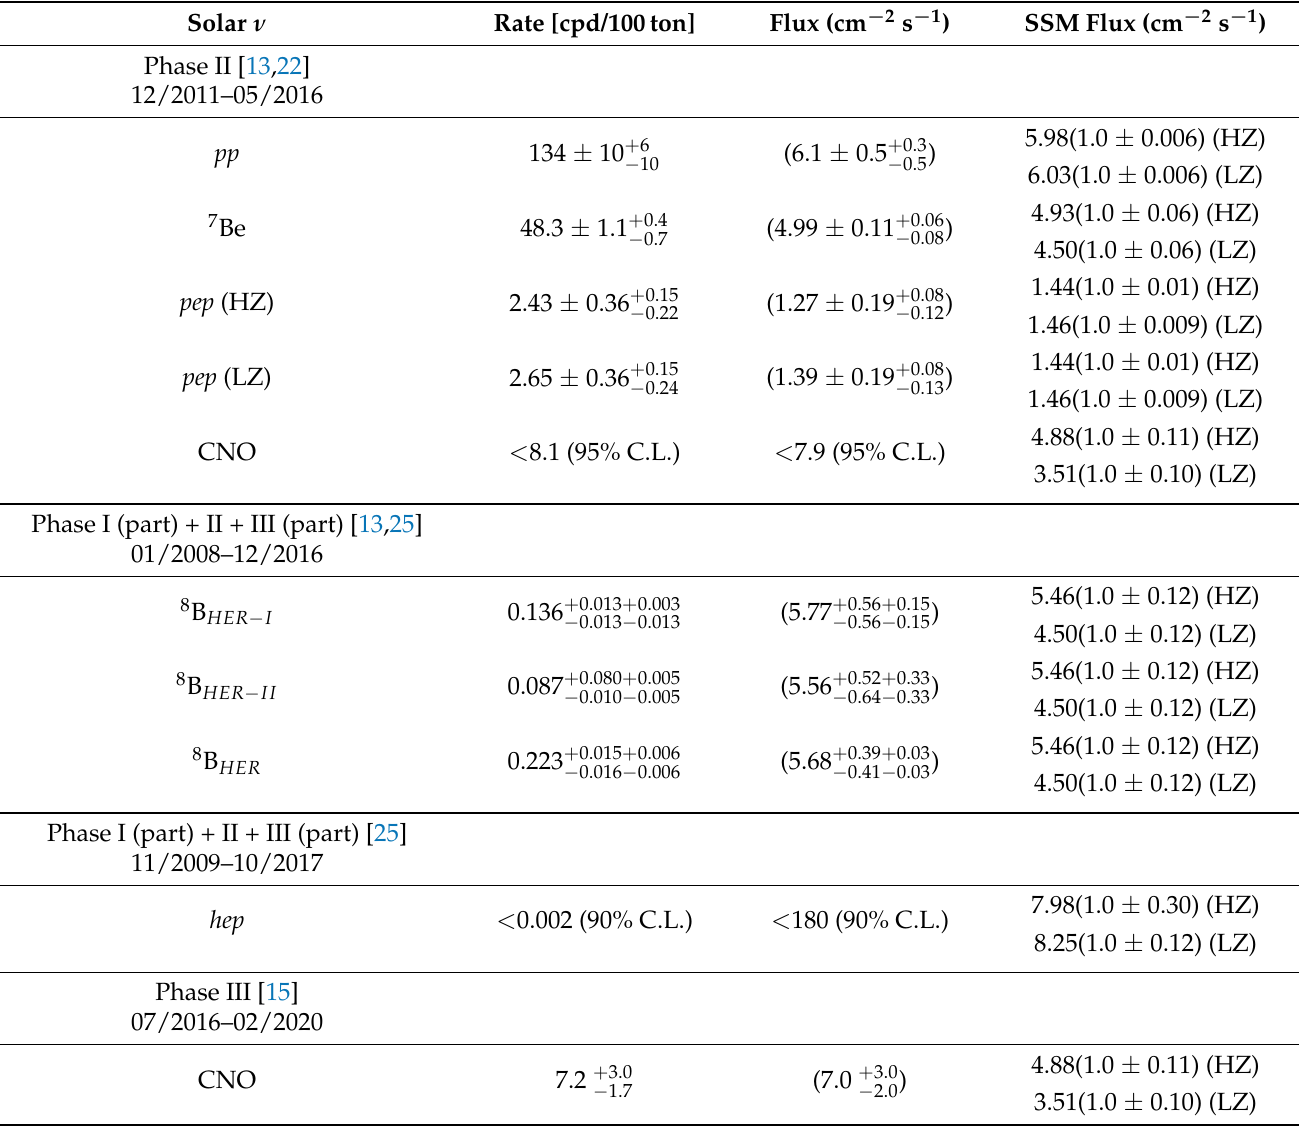
Table 5. Results of the Borexino Phase II [13] and Phase III [15] solar neutrino analyses. The rates and fluxes are integral values without any threshold; the first error is statistical, the second systematic. The rate-to-flux conversion assumes neutrino flavor conversion [62] with the neutrino oscillation parameters from [59]. The last column shows the fluxes as predicted by the HZ- and LZ-SSM [54] (see Table 3). The result for 7 Be neutrinos contains the ground and excited state lines as shown in Figure 4. The fluxes of pp , 7 Be, pep , CNO, 8 B, and hep neutrinos are normalized to 10 10 , 10 9 , 10 8 , 10 8 , 10 6 , and 10 3 (see Exp factor definitions in Table 3),